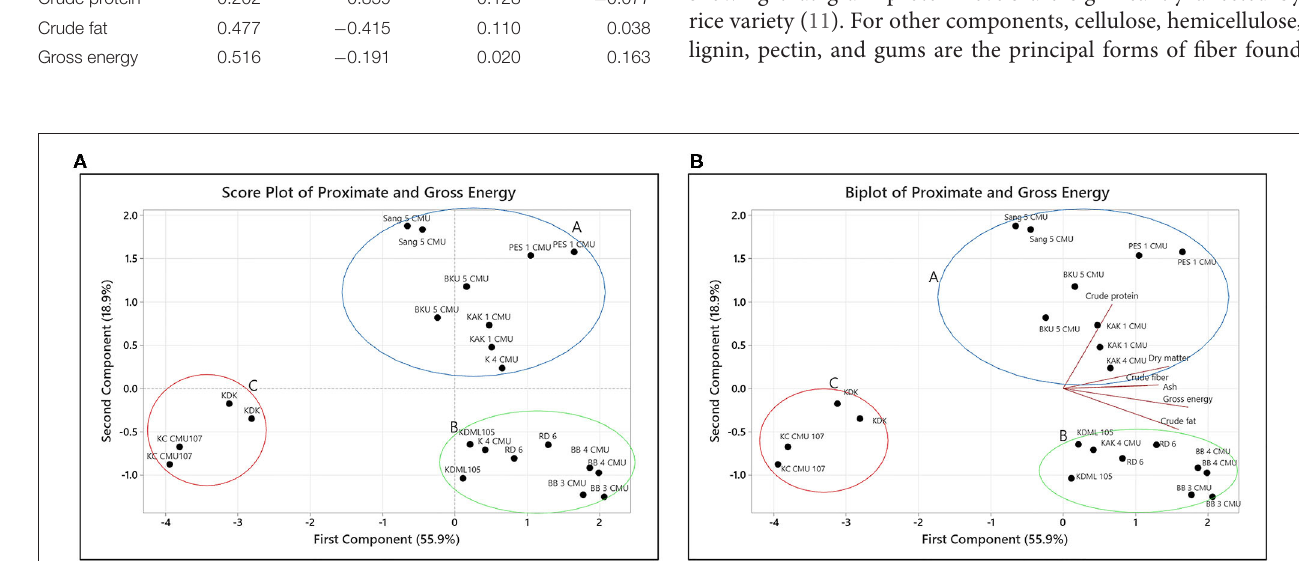
FIGURE 1 | (A,B) Principal Component Analysis of rice bran